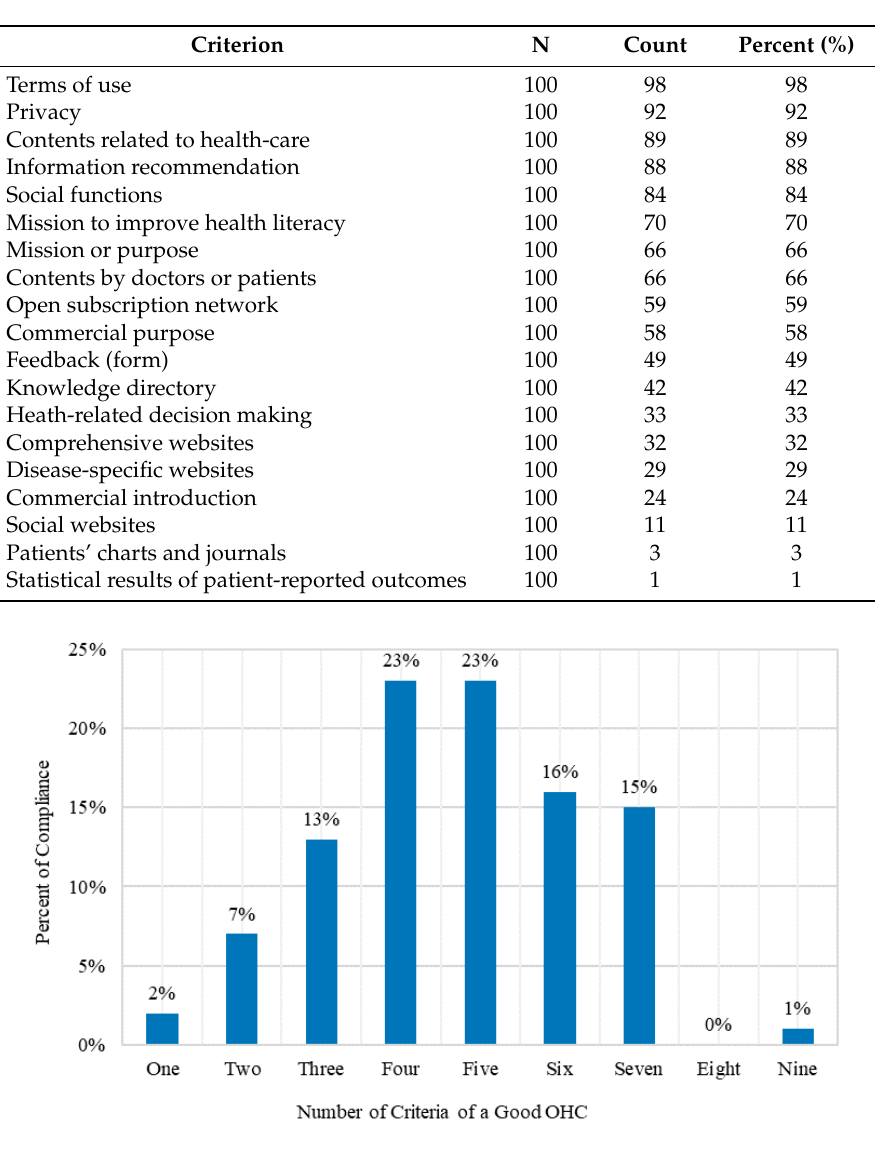
Table 3. Estimated percentages of websites in compliance to Health Communication and Health Information Technology (HC/HIT)-8.1 and required criteria of OHCs.